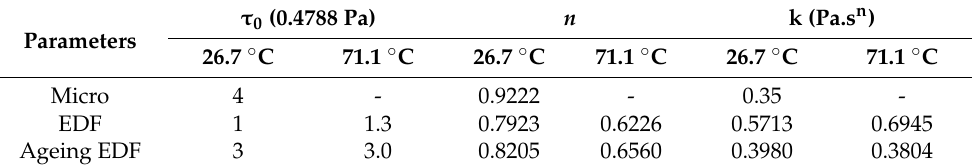
Table 3. Rheological parameters of the EDF fluid and microemulsion at 26.7 ◦ C and 71.1 ◦ C, before and after